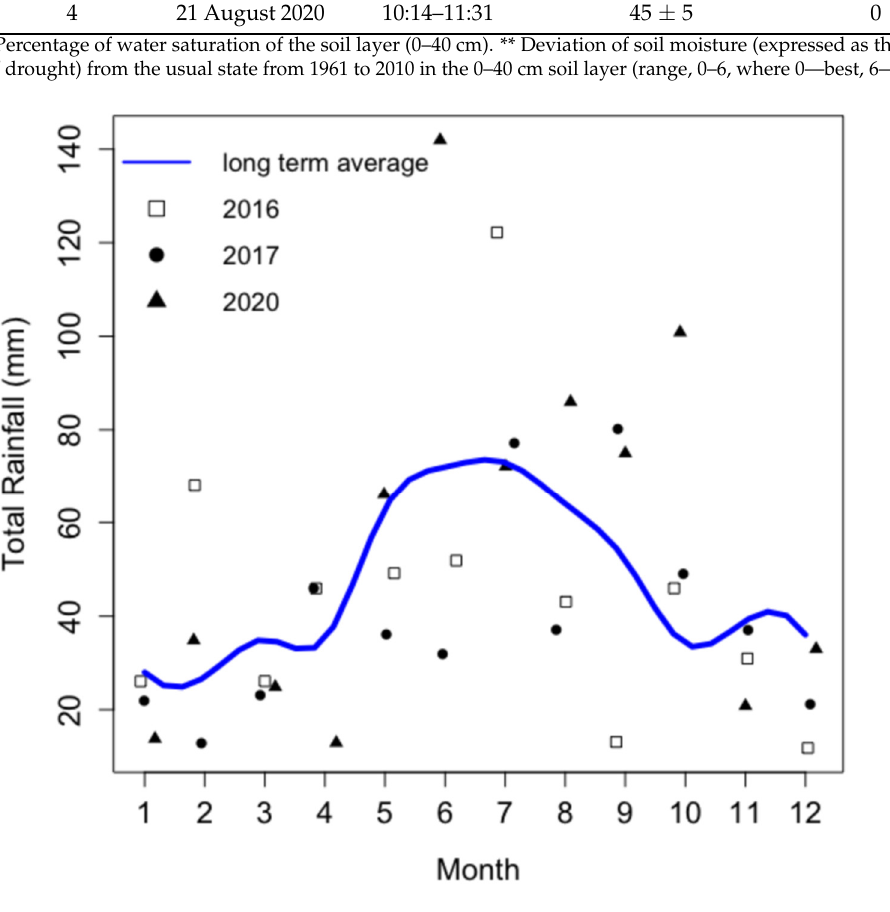
Figure 4. Total rainfall in individual years of processing. The line represents the long-term average for the period from 1981 to 2010.